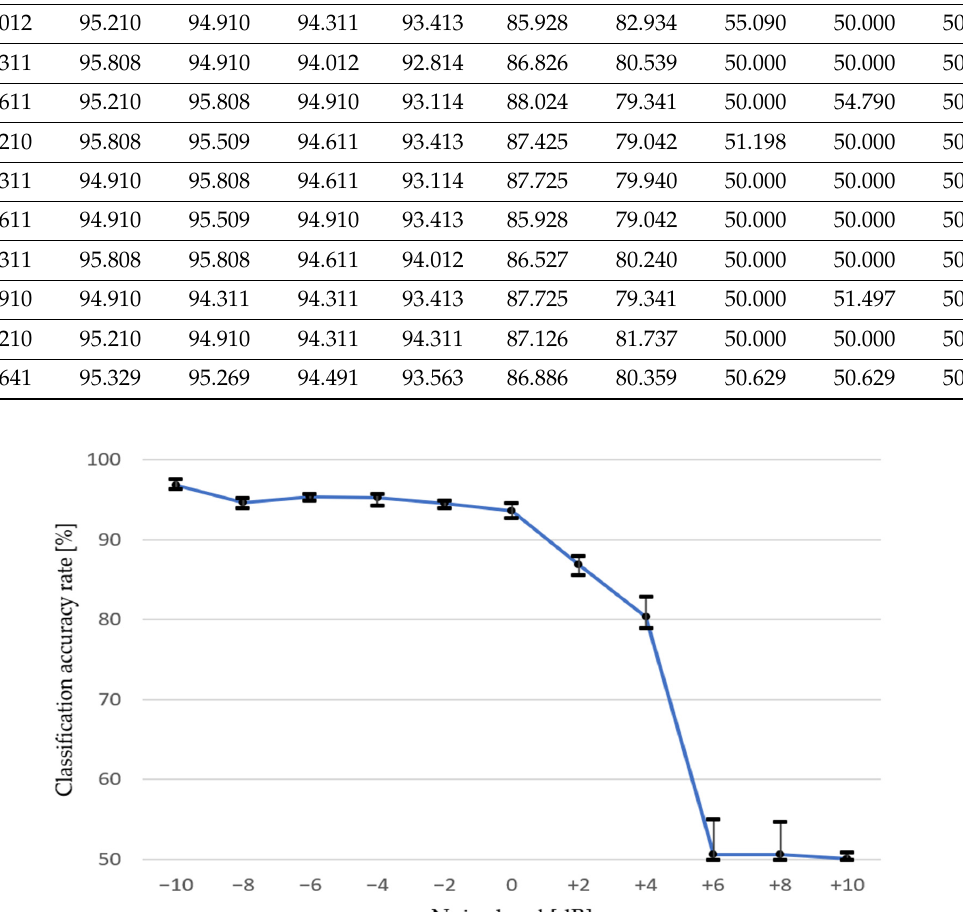
Table 5. Obtained classification accuracies [%] for datasets of spectrogram 2.